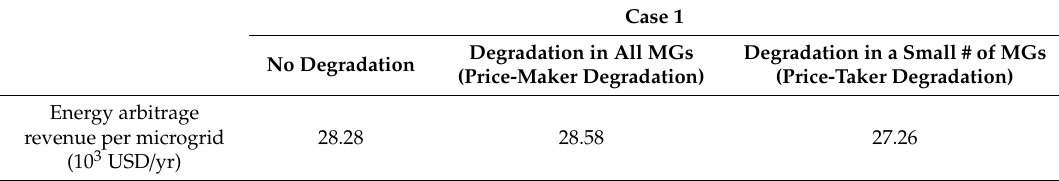
Table 4. Energy arbitrage revenues of a microgrid when degradation has been considered at di ff erent levels. In the last column, we show the revenues for an MG that includes degradation in its